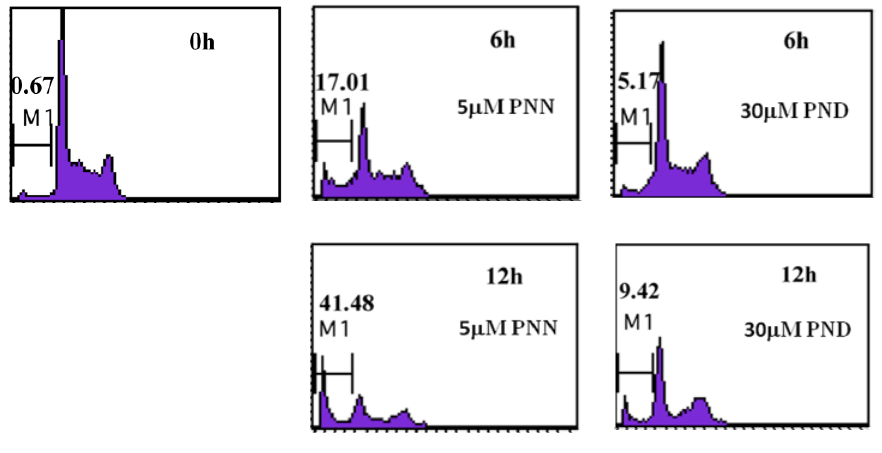
Figure 5. Flow cytometry analyses of nuclear DNA content. HL60 cells were treated with 5 μ M PNN and 30 μ M PND for the indicated time, the numbers in panel represent the M1 (sub-G1, hypodiploid) region, i.e. , the percentage of apoptotic cells and the values were the mean of